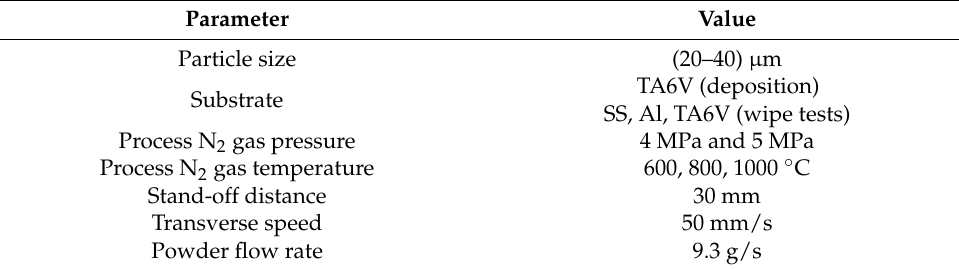
Table 2. Parameters of the Ti 3 AlC 2 cold spray